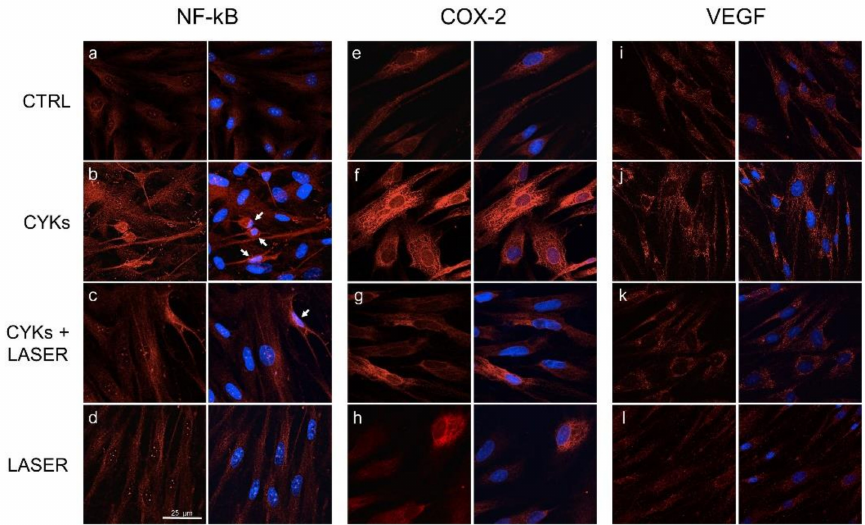
Figure 4. Laser treatment reduces inflammatory response in NHDF cells by limiting NF- κ B transloca- tion into the nucleus and down-regulating COX-2 and VEGF expression. Confocal analysis of NF- κ B (panels ( a – d )), COX-2 (panels ( e – h )) and VEGF (panels ( i – l )) expression and localization (magnifi- cation 63 × ) evaluated by immunofluorescence on NHDF in basal conditions (CTRL; panels ( a , e , i )), stimulated with IL-1 β and TNF- α for 48 h (CYKs; panels ( b , f , j )), stimulated with IL-1 β and TNF- α for 48 h, and then exposed to laser treatments (3 treatments, repeated once a day, for 3 consecutive days) (CYKs + LASER; panels ( c , g , k )) and exposed to laser alone (LASER; panels ( d , h , l )). For each series, the left panels show the protein of interest in red, while DAPI staining (blue) was merged on the right panels. White arrows indicate cells with nuclear localization of NF-kB. Bar = 25 µ